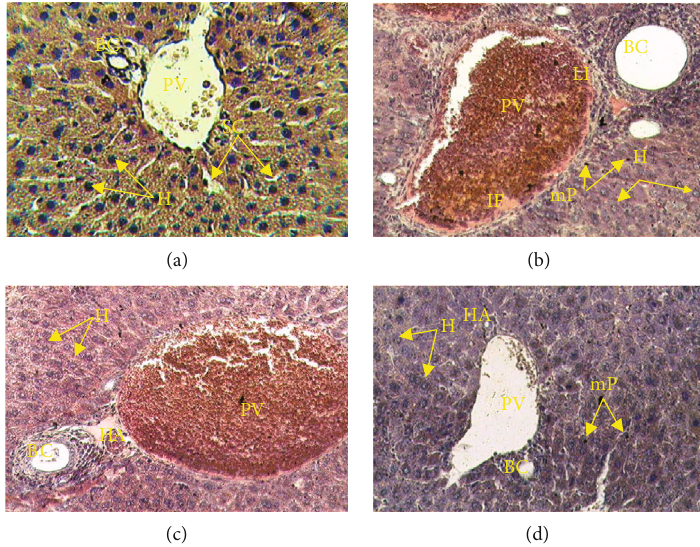
Figure 5: Photomicrograph of the e ff ects of Tm sb w on the histology of mouse liver infected by Pb B: (a) uninfected mice, (b) untreated mice, (c) chloroquine-treated mice, and (d) Tm sb w -treated mice; HE × 400. HA: hepatic artery; BC: biliary canal; PV: portal vein; H: hepatocyte; SC: sinusoid capillary; H: dilate hepatocyte; LI: leucocyte in fi ltration; mP: malarial pigment; FI: in fl ammatory focal